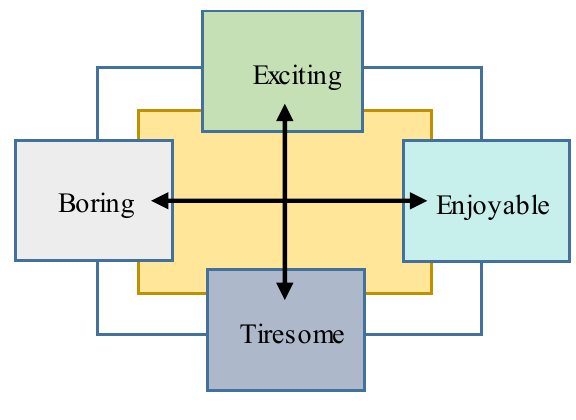
Figure 2: Selected Reactionary Behavior (Source: the Figure 2. Selected reactionary behavior